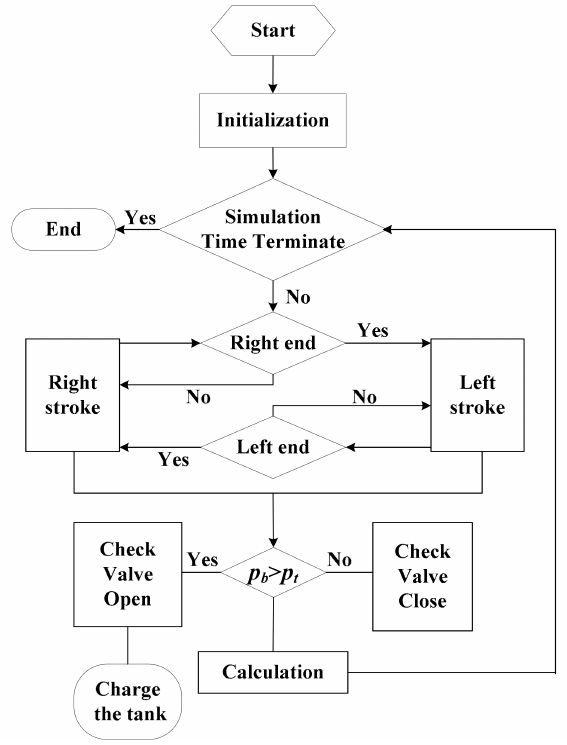
Figure 4. Flow chart of simulation